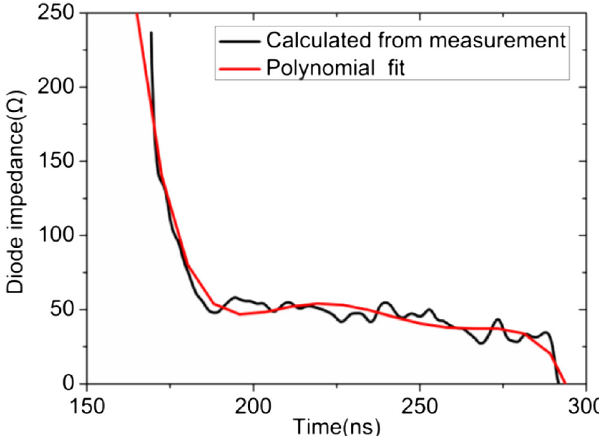
FIG. 4. Diode impedance trace used in the circuit simulation. The black line is the calculated impedance from electrical mea- surements of shot 19-007 according to Eqs. (1) and (2), and the red line is a fifth-order polynomial fit curve used in the